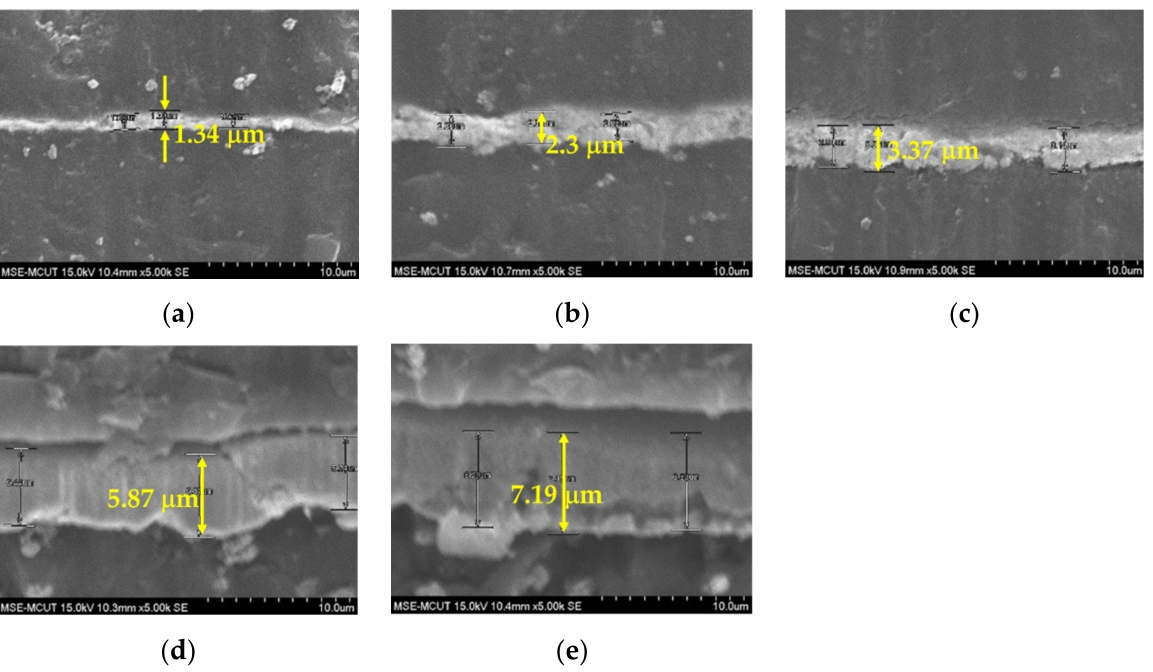
Figure 9. Cross-section views of silver films obtained with ( a )one, ( b ) two, ( c ) three, ( d ) four, and ( e ) five